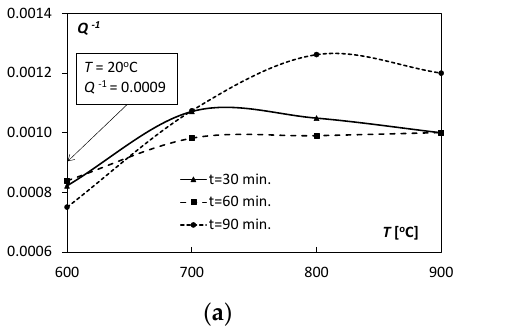
Figure 4. Dependence of the internal friction parameter Q − 1 on: ( a ) temperature T , ( b ) annealing time t .